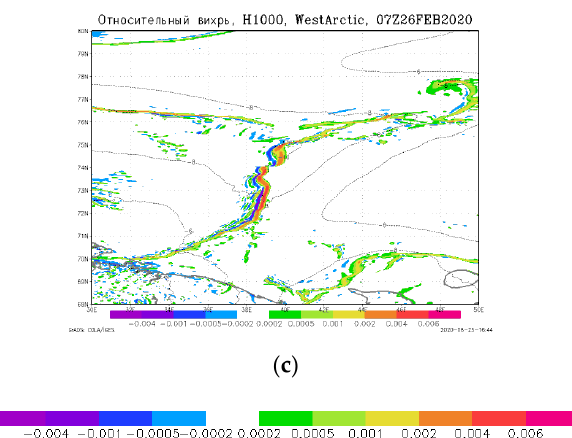
Figure 13. ICON ‐ A2 relative vorticity (1/s): ( a ) profile along 73° N; ( b ) profile along 38.5° E; ( c ) vorticity map at H 1000 . Valid time, 06:00 UTC 26 February 2020.